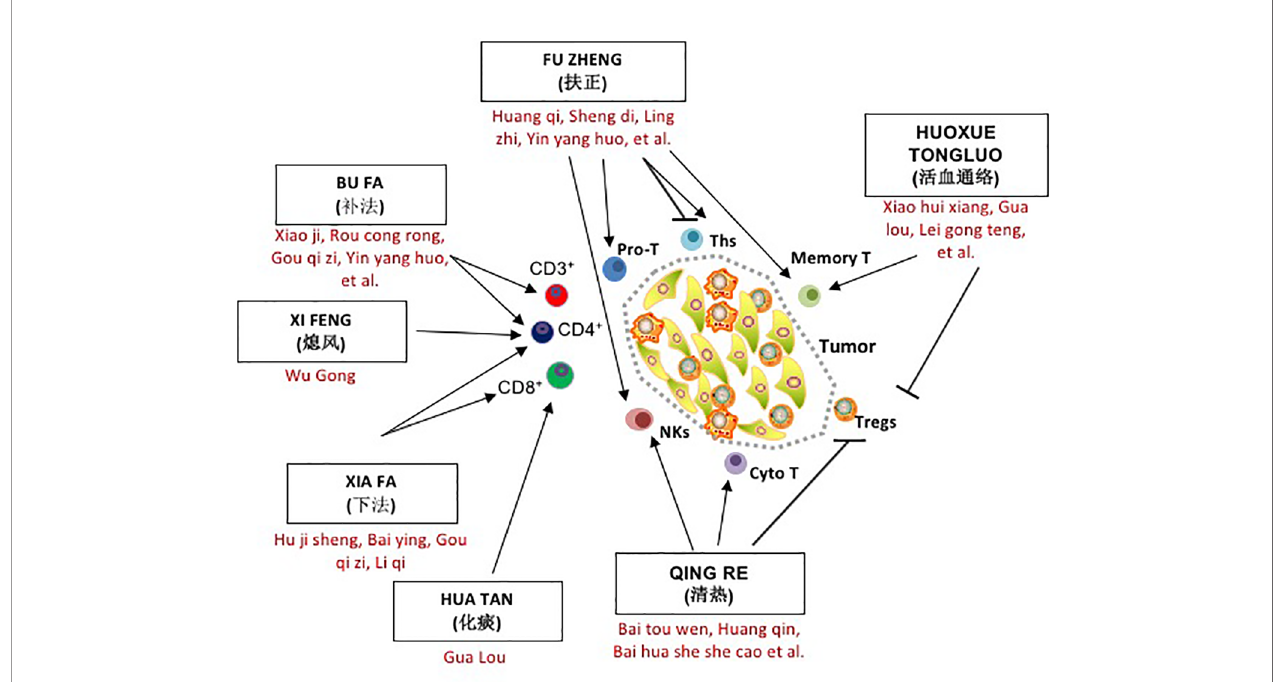
FIGURE 1 | The role of seven traditional Chinese medicine (TCM) herbal methods in T cell regulation and tumor progression. Cyto T, cytotoxic T cell; Memory T, Memory T cell Tm; NKs, Natural Killer cells; Pro T, T lineage progenitor; Tc or cytotoxic T lymphocyte; Ths, helper T cell; Tregs, regulatory T cell.